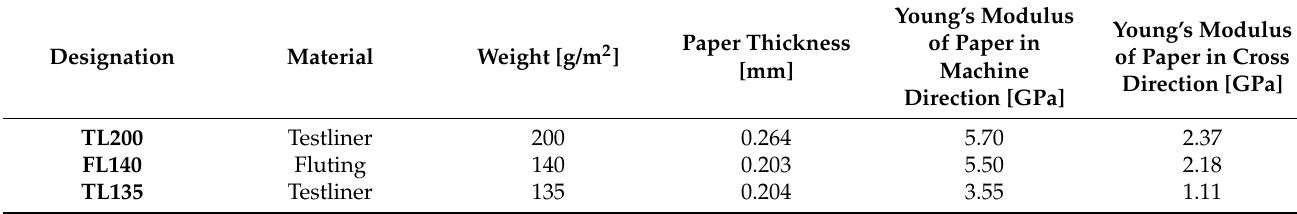
Table 2. Physical characteristics of the